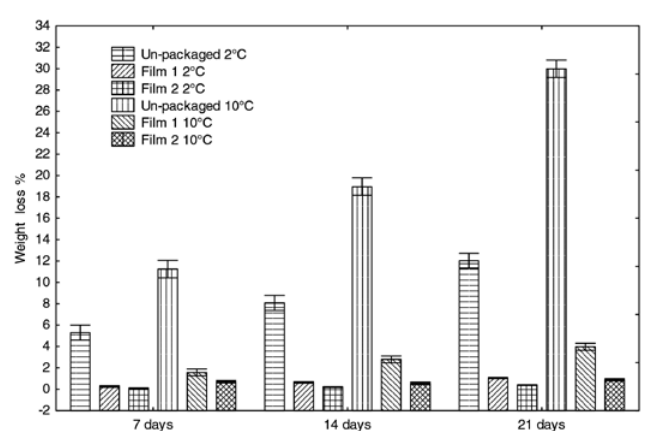
Fig. 2 - Influence of film packaging and storage conditions on weight loss in green asparagus. Vertical bars represent LSD, P ≤